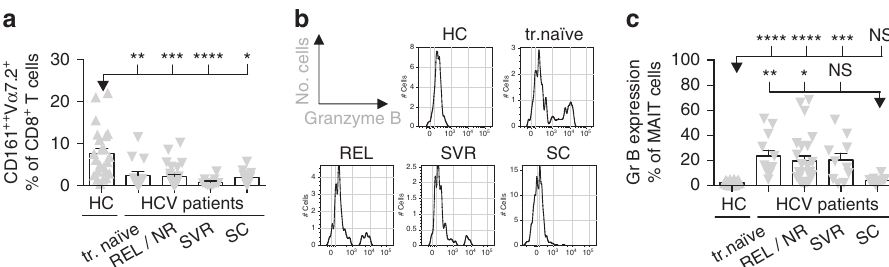
Figure 2 | MAIT cell activation during chronic viral infection in vivo. PBMC’s from healthy controls ( n ¼ 20–23) or patients ( n ¼ 12–25) with persistent (treatment naive, REL, NR) and resolved HCV infection (SVR, SC) were analysed by flow cytometry by gating on live CD3 þ CD8 þ CD161 þ þ V a 7.2 þ (MAIT) cells. ( a ) MAITcell frequency as a proportion of the CD8 þ Tcells. ( b , c ) Granzyme B expression by MAITcells. ( b ) Representative flow cytometry plots. Bars represent means ± s.e.m. Statistical significance was determined with the Kruskal–Wallis test followed by the Dunns’ test. ns 4 0.05, * P 0.05, ** P r 0.01, *** P r 0.001, **** P r 0.0001. HC, healthy control; Gr B, Granzyme B; REL/NR, relapse/non-response; SC, spontaneous clearance; SVR, sustained virological response; tr.,